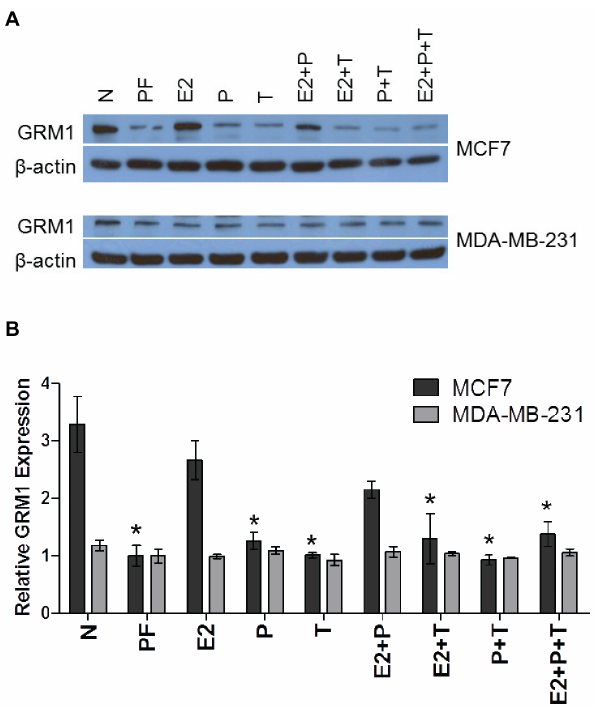
Figure 5. 17 b -estradiol induction of GRM1 protein expression in ER + breast cancer cells is abrogated by 4-hydroxytamoxifen. MCF7 (ER + /PR + ) and MDA-MB-231 (ER 2 /PR-) breast cancer cells were treated with 17 b -estradiol (E2), progesterone (P), 4-hydroxytamoxifen (T), or a combination of hormonal agents for a total of 48 h. (A) Western blot analysis uses b -actin for protein loading control. N=normal growth medium, PF=phenol-free, charcoal-stripped growth medium. (B) Quantitation of western blots from three independent experiments. Data represent the mean value of triplicate experiments + / 2 SE. * P , 0.05 compared to E2 treatment.